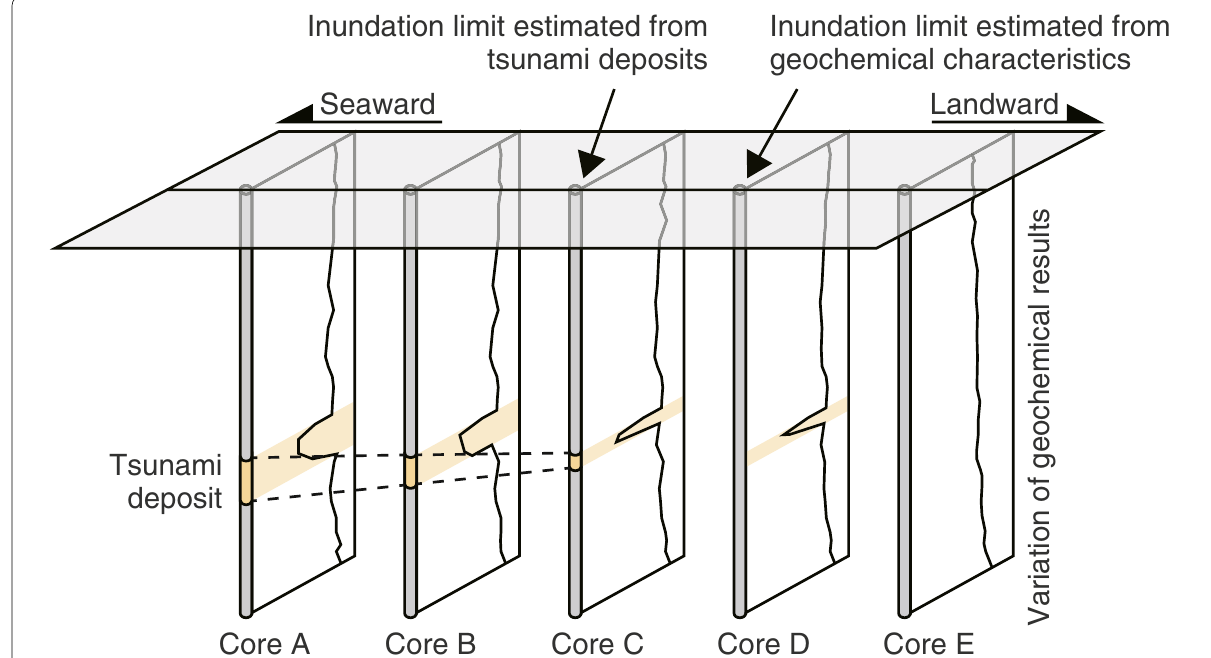
Fig. 4 Conceptual scheme of the results of a geochemical analysis of core sediments obtained along a transect across a coastline. The inundation limit estimated from the distribution of visible (sandy) tsunami deposits is at Core C, whereas the limit is placed further inland (Core D) if geochemical characteristics are